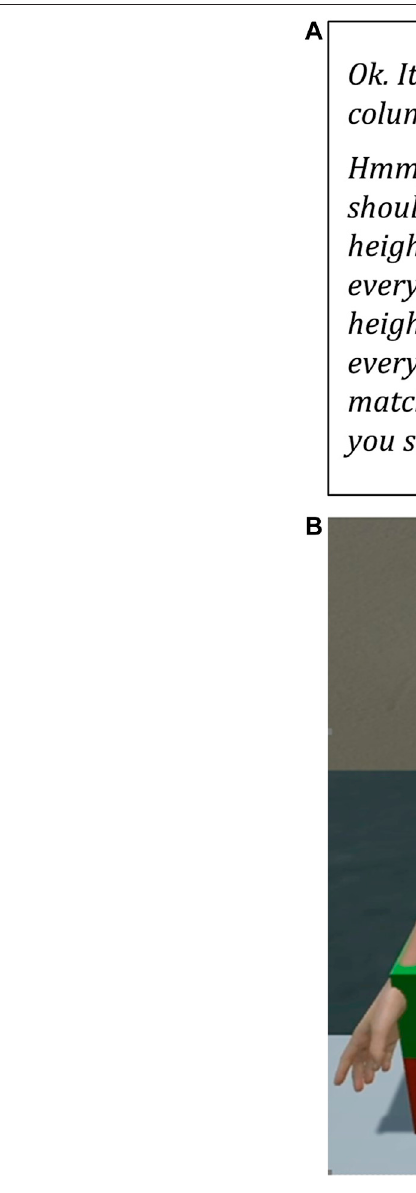
FIGURE2| Unduedistraction:EarlyversionsoftwodifferentCwCsystemsdemonstratenegativeexamplesofHallmarkHE-4: Themachinecommunicateswithout creatingunduedistraction . (A) Adistracting(hardtounderstand)machine-generateddescriptionofaconstraintlearnedbyanearlyversionoftheCABOTsystem(Perera et al., 2018). (B) A distracting (physically impossible) machine-generated visualization in an early version of the Diana system (Pustejovsky